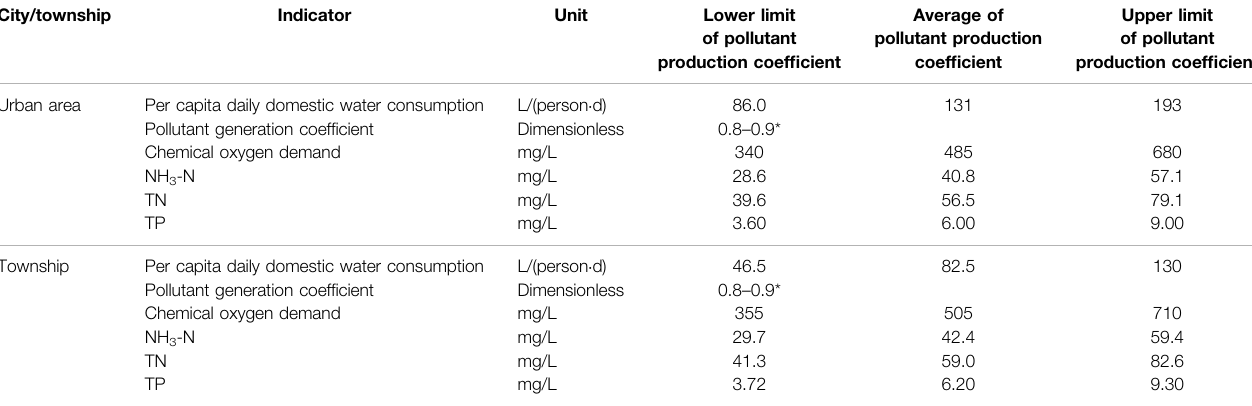
TABLE 1 | Pollutant production check coef fi cients of water pollutants from urban domestic sources in the study area. City/township